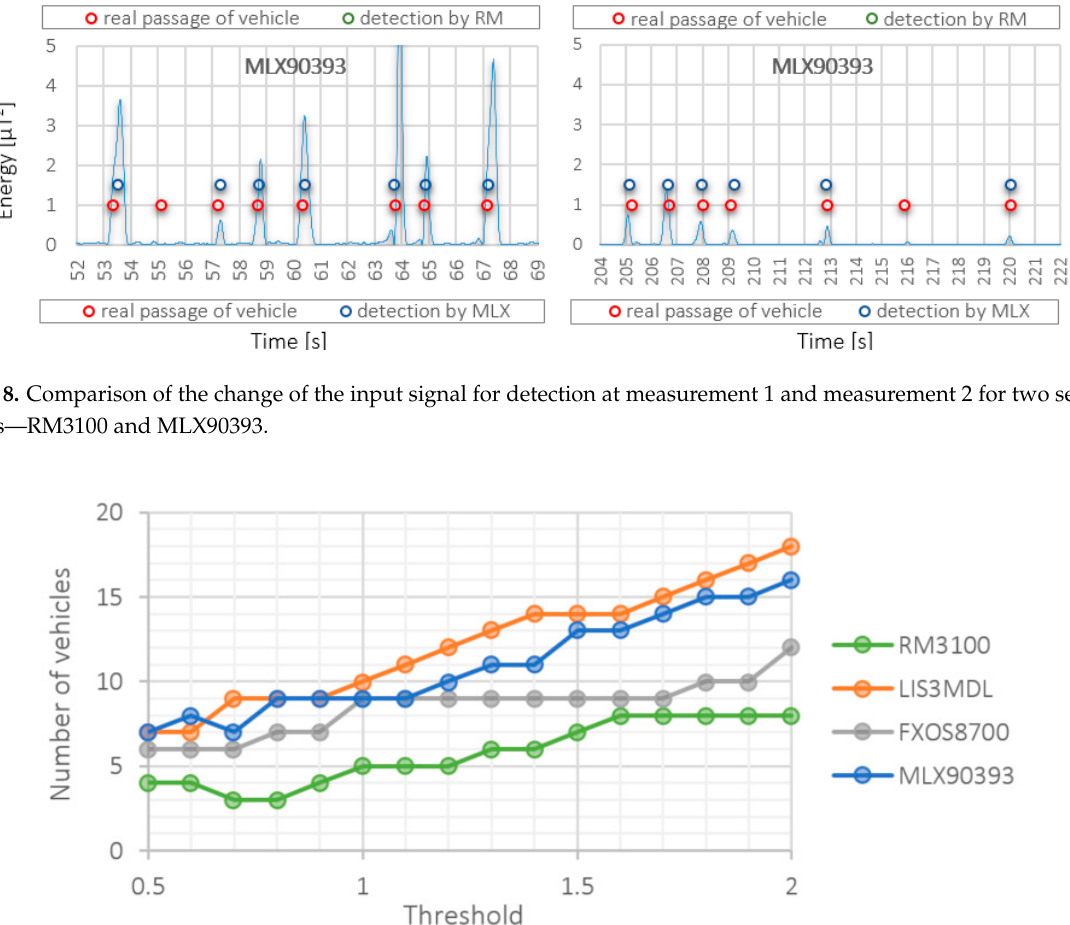
Figure 10. Number of false positives at different threshold level.